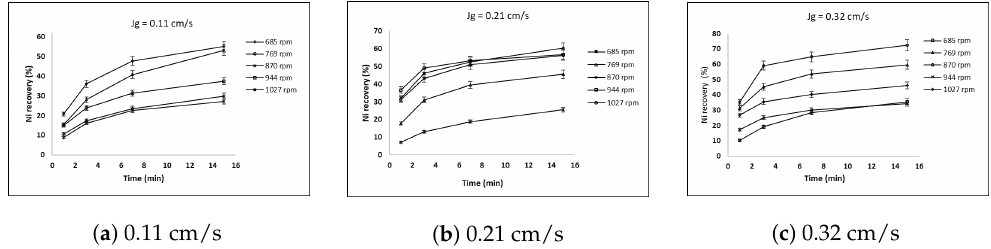
Figure 14. Recovery of nickel vs. time using different J g values ( a ) 0.11 cm/s, ( b ) 0.21 cm/s and ( c ) 0.32 cm/s) with a 7 cm diameter